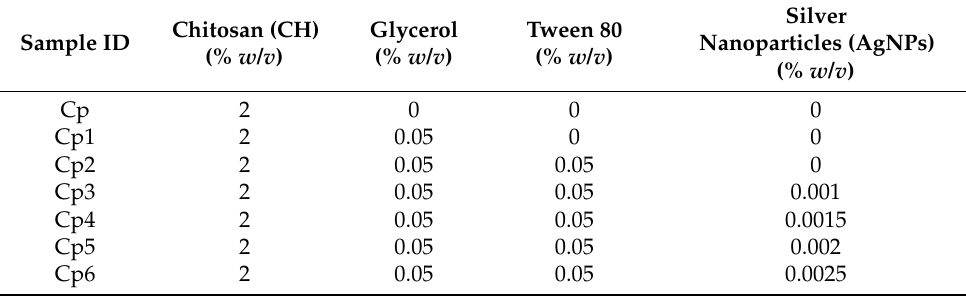
Table 1. Composition of CH